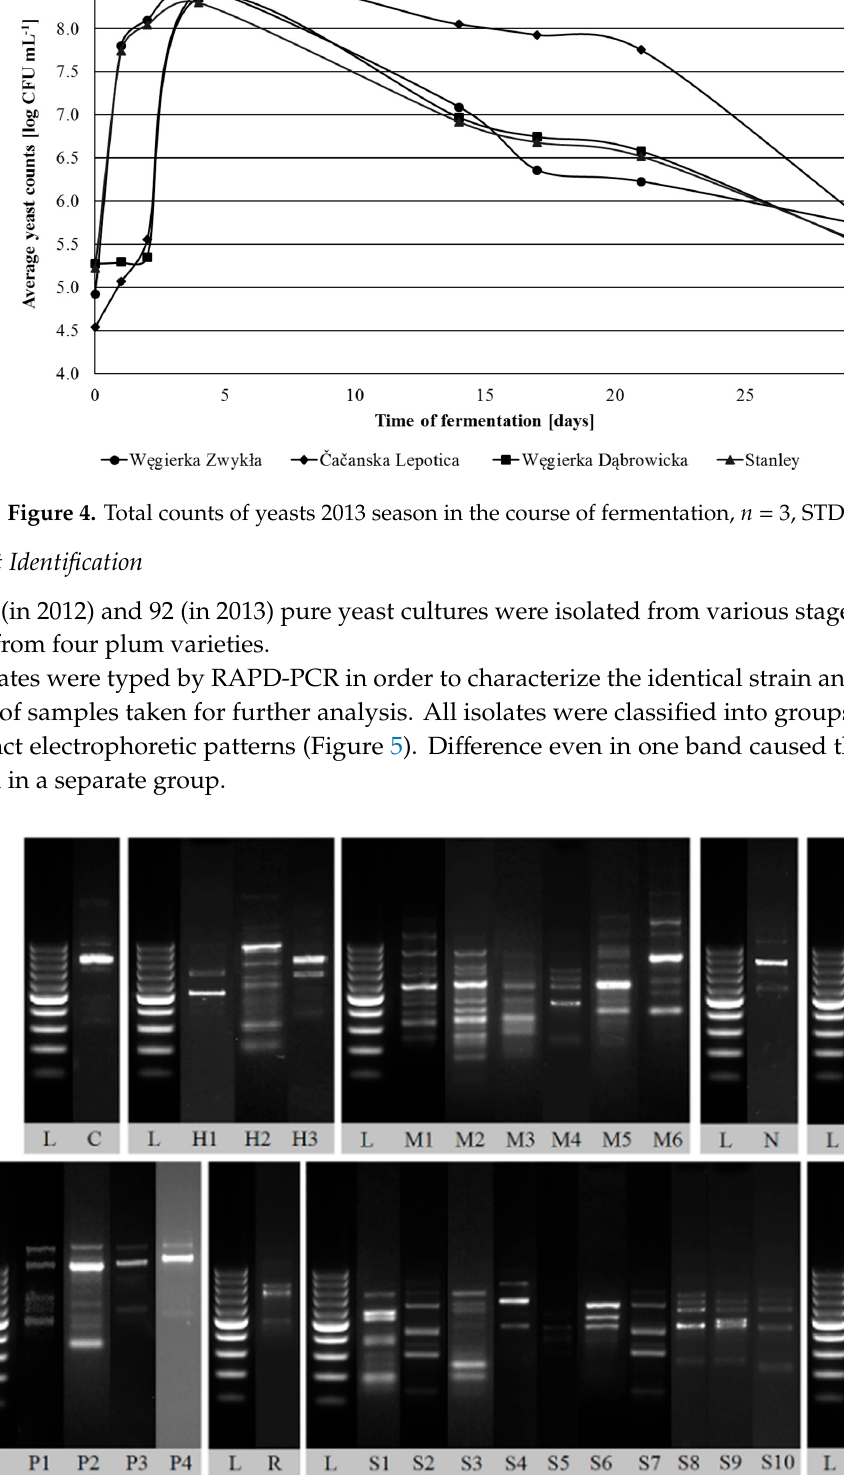
Figure 5. Representative random amplification of polymorphic DNA (RAPD) patterns obtained with